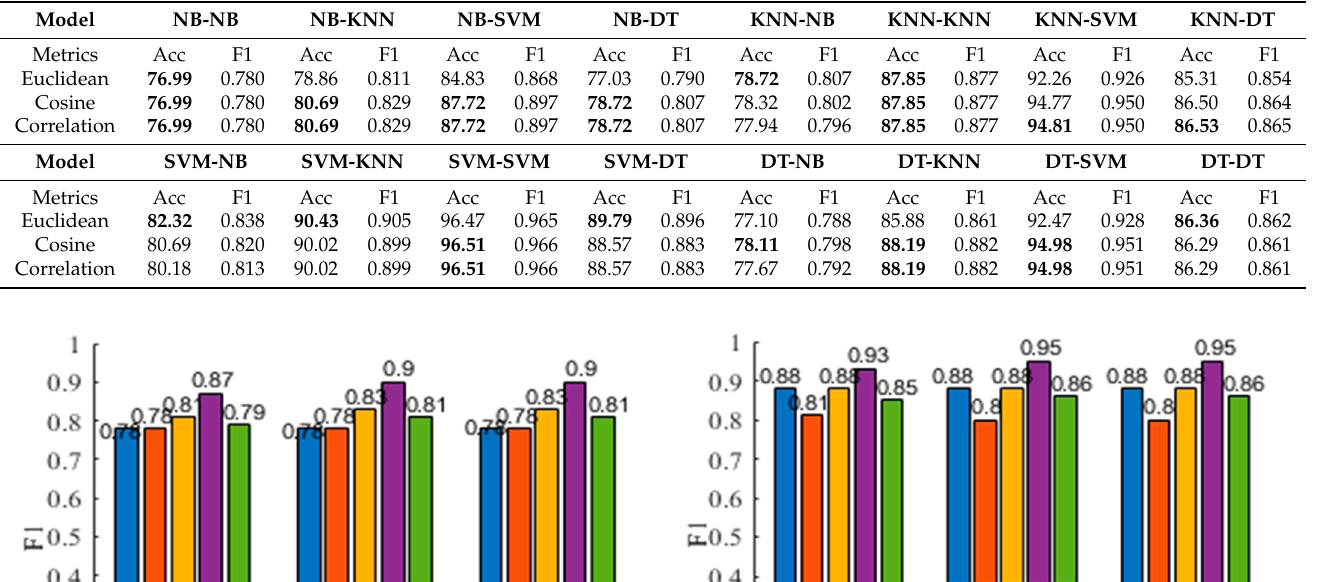
Table 6. Performance of different distance metrics for k -means on UCI-HAR.